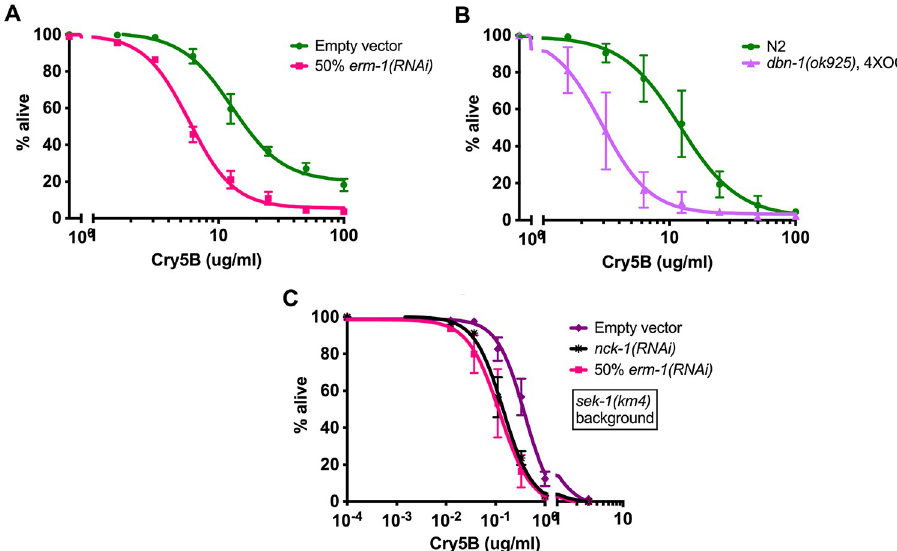
Fig 7. nck-1 genetically functions in the same pathway as other F-actin-interacting proteins in PFP defense. (A) Wild-type N2 C . elegans were grown from the L1 to L4 stage on E . coli expressing the indicated RNAi, then transferred to liquid culture with purified Cry5B for 6 days and assayed for survival. (B) N2 or mutant worms were grown on OP50 E . coli to the L4 stage, then transferred to liquid culture with purified Cry5B for 6 days and assayed for